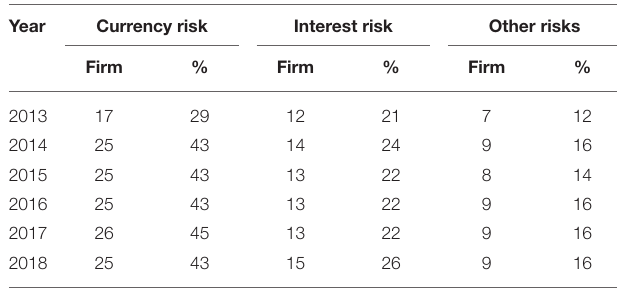
TABLE 3 | Derivative product usage levels by sectors. TABLE 4 | Companies using derivatives by financial risk type.